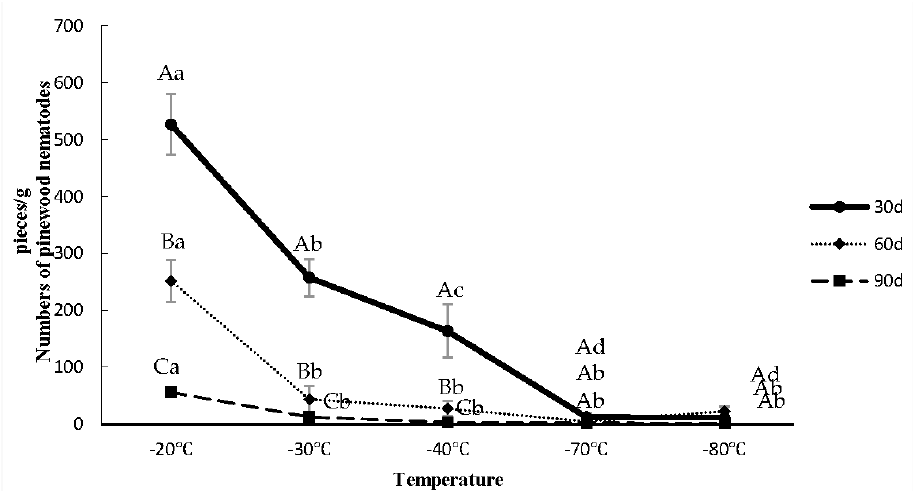
Figure 1. Survival of Bursaphelenchus xylophilus third-stage dispersal juveniles in Pinus tabuliformis after being subjected to different temperature stress. Note: The first capital letter indicates a significant difference in B. xylophilus numbers between treatment times. The second lowercase letter indicates a significant difference in B. xylophilus numbers at different temperatures.